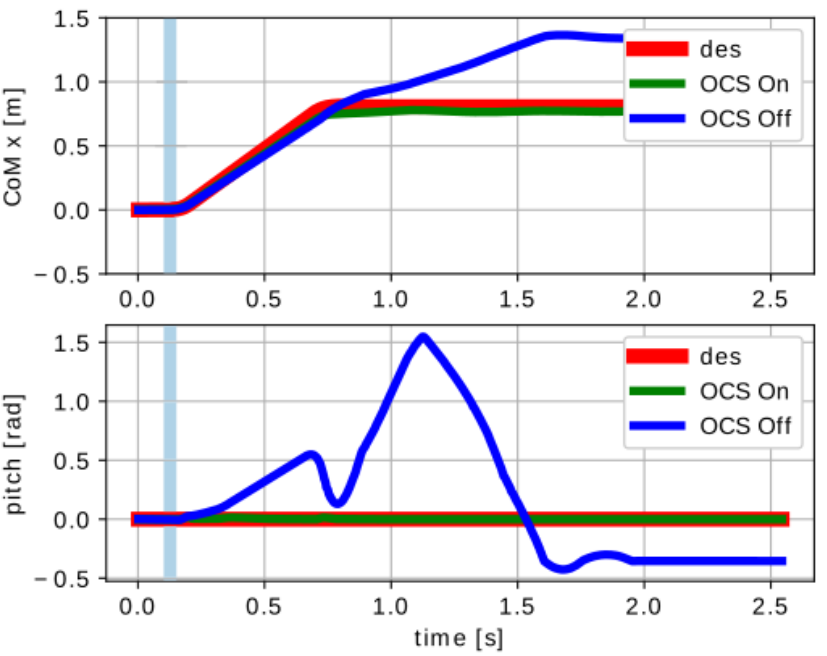
Figure 8. First Test: simulation results showing the CoM x and pitch trajectory vs. time plots. A disturbance moment τ dist on the trunk could be compensated for only if the OCS was enabled. If it was disabled, the robot was unable to restore a safe configuration after touch-down and, eventually, fell. The light blue area represents the interval of time in which the disturbance was applied.